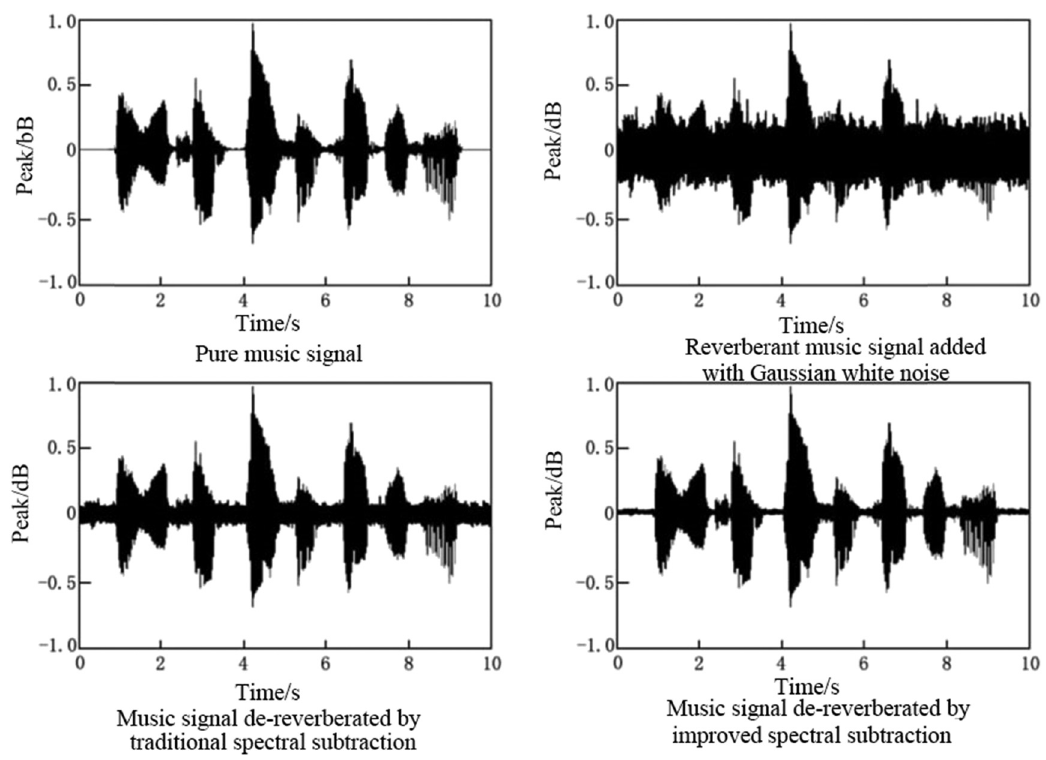
Figure 2: The pure music signal, the music signal added with noise, and the music signals de - reverberated by the two spectral subtraction